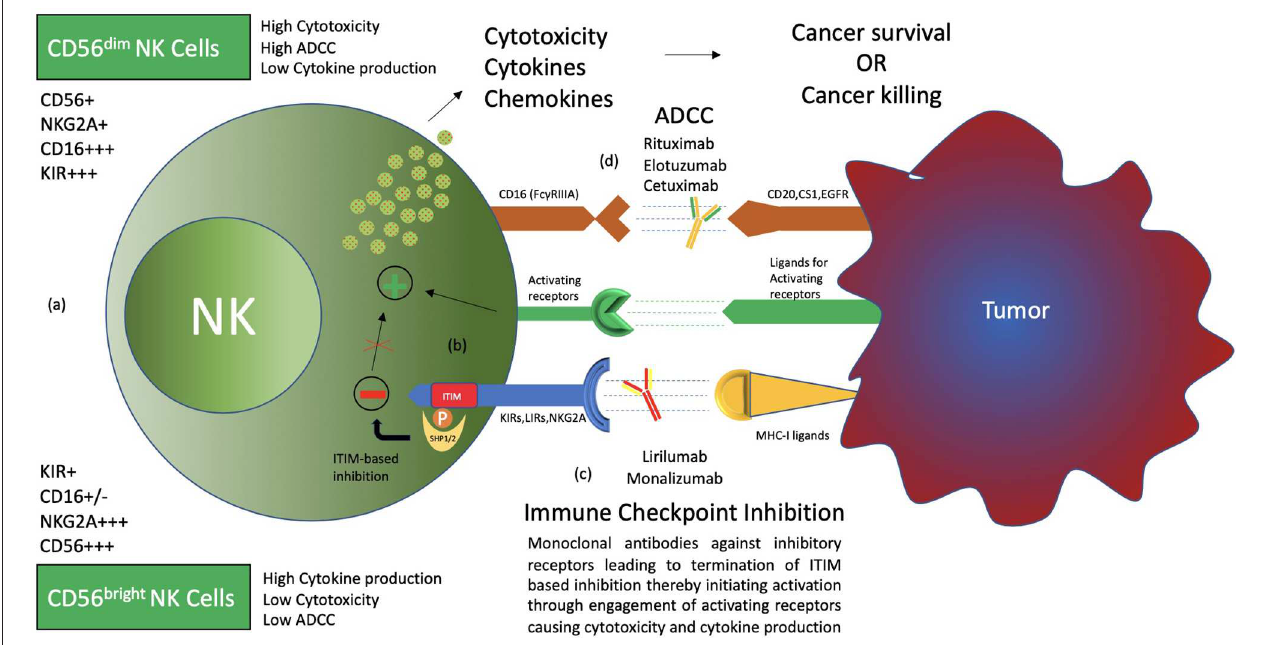
FIGURE 1 | Types and functions of NK cells. (a) CD56 bright CD16 − and CD56 dim CD16 + NK cells, termed immature and mature NK cells, respectively, are identified to have functional differences. CD56 bright NK cells produce more cytokines, while CD56 dim CD16 + NK cells are more cytotoxic and carry out ADCC (antibody-dependent cell-mediated cytotoxicity). (b) NK cell surface receptors, both activating and inhibitory receptors, carry out NK cell functions through a balance of signals. Inhibitory receptors detect MHC-I ligands on normal cells, and if present, activating signals are terminated, thereby maintaining “self-recognition.” These receptors carry ITIM motifs in their cytoplasmic tail, which recruit SHP1/2 through phosphorylation to carry out its function. Such inhibition is termed “dominant inhibition.” (c) Inhibitory receptors are exploited by cancer through upregulation of ligands, thereby avoiding destruction by NK cells. Hence, antibodies such as lirilumab and monalizumab are developed to block such interaction and enhance NK cell cytotoxicity toward cancer cells. This phenomenon is termed immune checkpoint inhibition. (d) The presence of CD16 receptors on NK cells makes them able to carry out ADCC. Therefore, several antibodies, such as rituximab, elotuzumab, and cetuximab, have been clinically evaluated for synergism with immune checkpoint